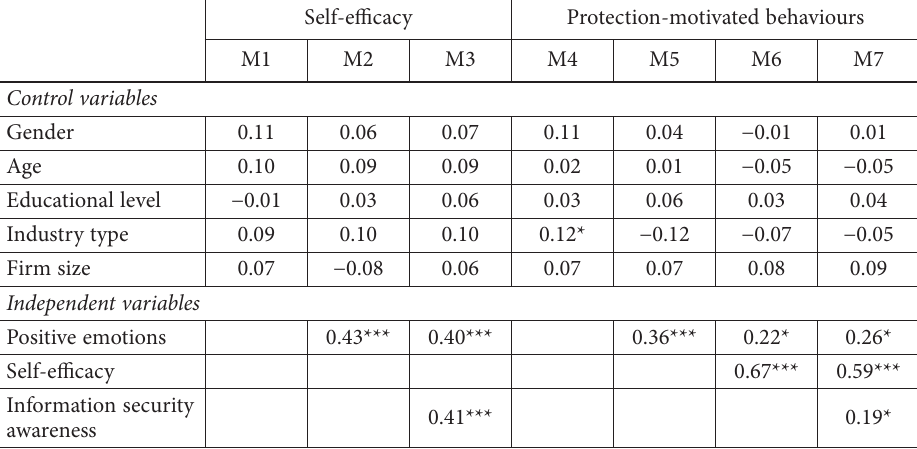
Table 5. Results of regression